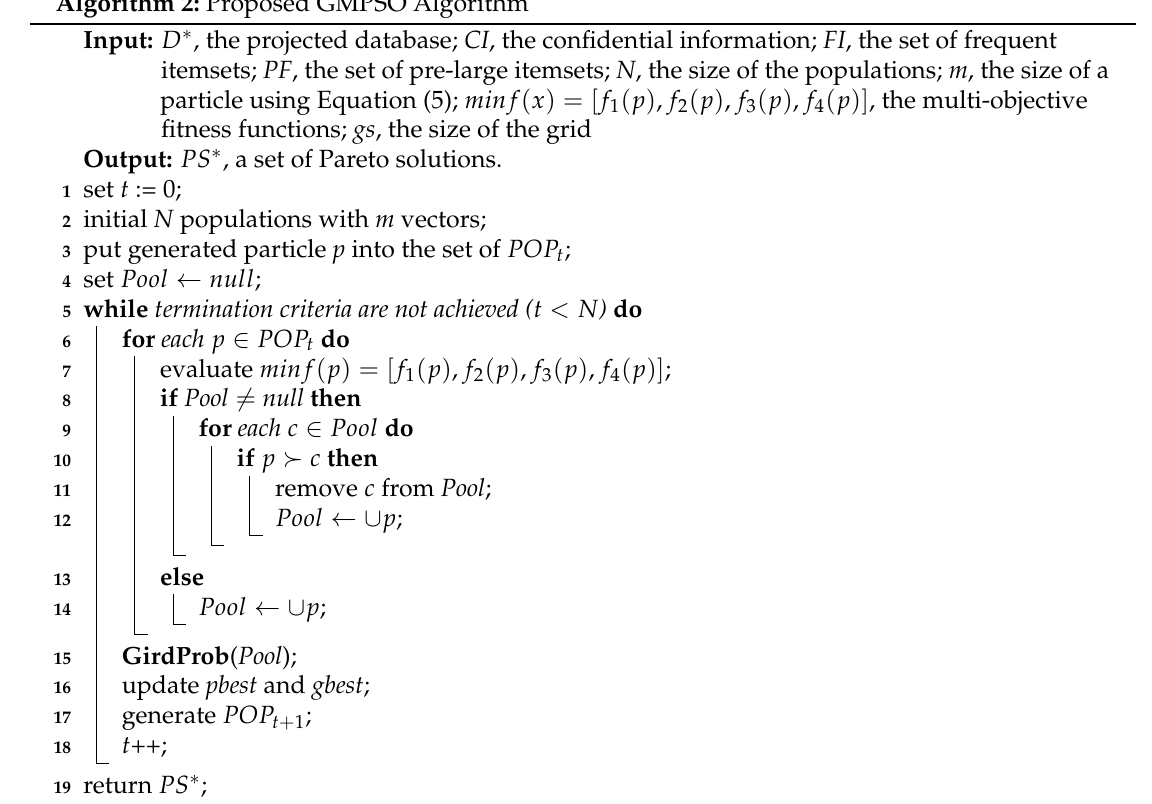
Algorithm 2: Proposed GMPSO